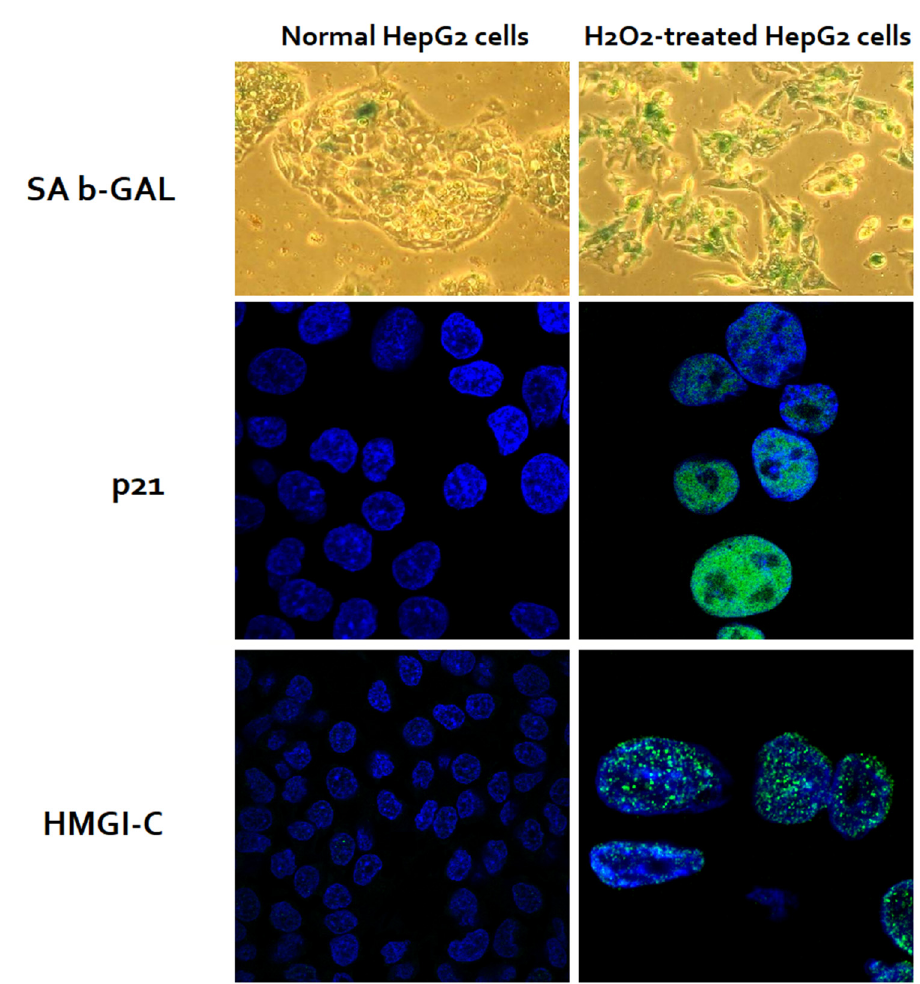
Figure 3. Induction of senescence I HepG2 cells through oxidative stress using H 2 O 2 . Of the cells, >95% of H 2 O 2 -treated HepG2 cells and <5% of untreated HepG2 cells expressed SA- β -GAL (green staining). H 2 O 2 -treated HepG2 cells were enlarged, and flattened with significantly larger nuclei. More than 95% of the H 2 O 2 -treated, but none of the untreated HepG2 cells, expressed p21 (a cell cycle inhibitor, green nuclear stain). Similarly, more than 90% of the H 2 O 2 -treated, but none of the untreated HepG2 cells, expressed HMGI-C (a senescence-associated heterochromatic foci,